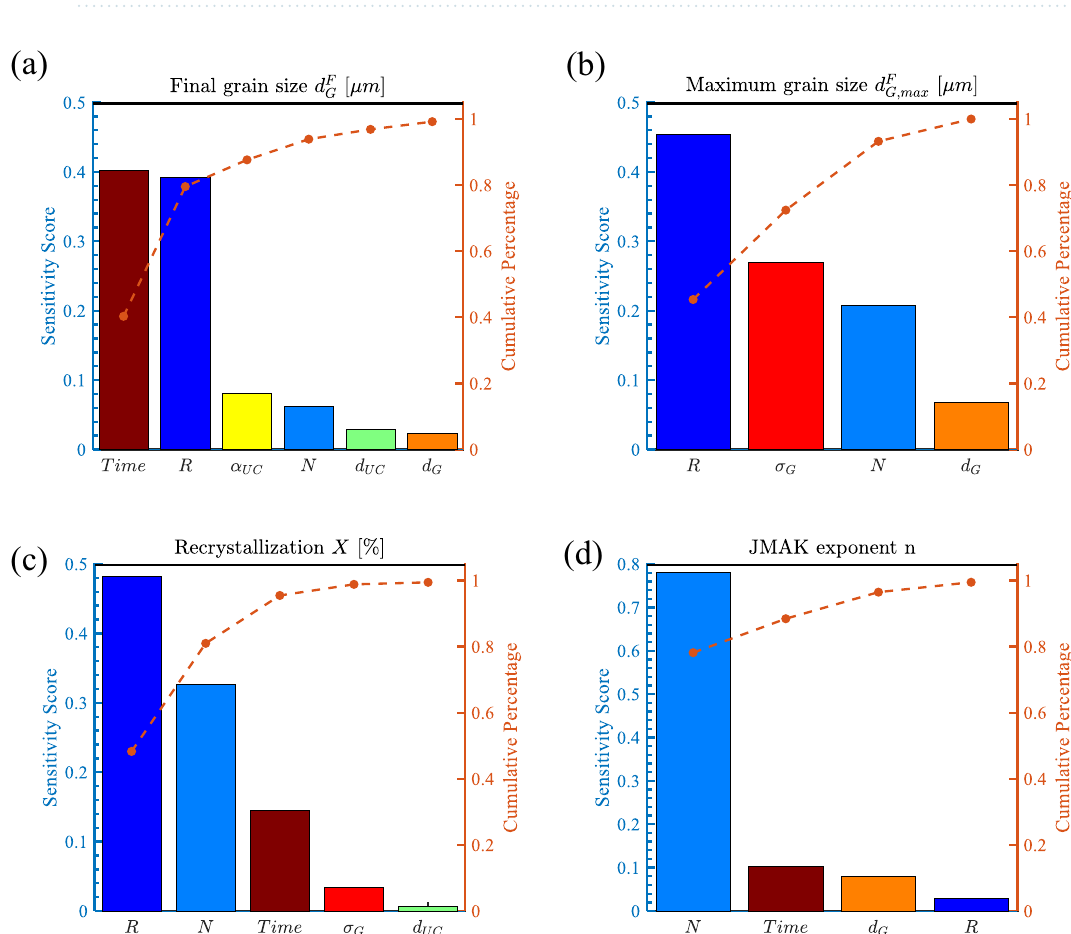
Figure 3. Pareto plots showing the sensitivity score ranking of the simulation parameters on the final U-10Mo alloy microstructure. ( a ) Final grain size d and (d) JMAK exponent n